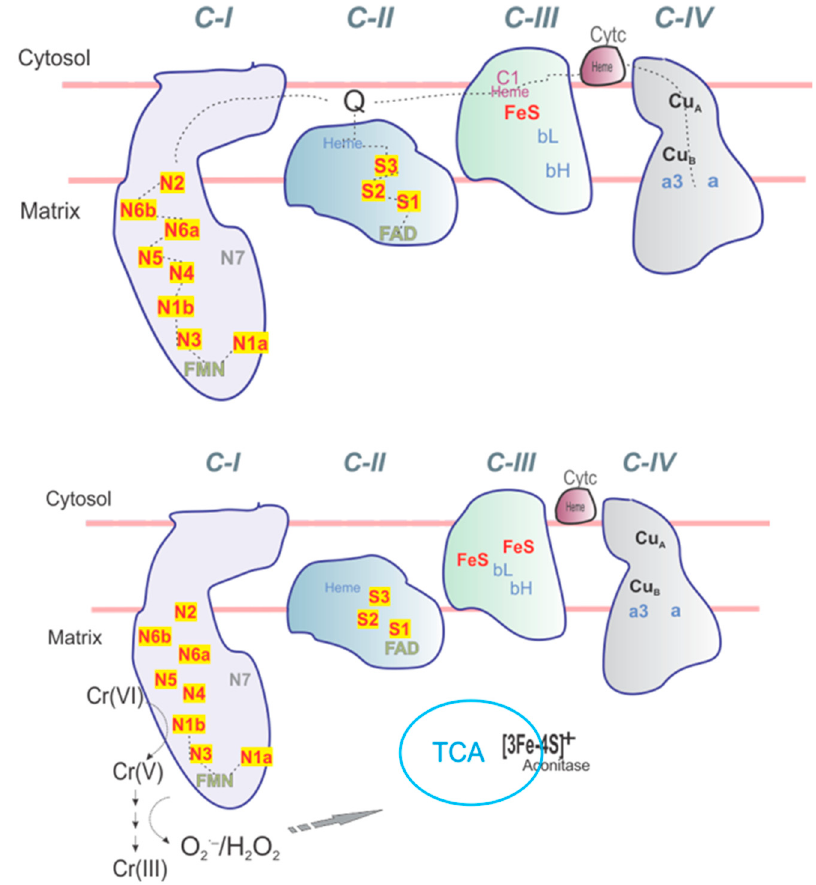
Figure 1. Mitochondrial iron cluster organization and EPR signals. (Upper panel) Mitochondrial Respiratory Complexes (CI–CIV). The hydrophilic domain and iron sulfur clusters of CI: N1a, N1b (2Fe2S) only. N1b is detected at g = 1.94 and 2.02. The clusters N2, N3, N4, N5 are (4Fe4S) with typical signals at g = 2.05 for N2; g = 2.04 and 1.87 for N3; g = 1.89 for N4. Mitochondrial C-II contains S1 (2Fe2S), S2 (4Fe4S) and S3 (3Fe4S) complexes with signals at g = 2.02, 1.93 (S1), g = 2.02 (S3), respectively. (Lower panel) changes in EPR signals upon addition of chromate including contribution of inactive aconitase (3Fe4S)+; g = 2.02. Note: only partial g-values of interest are given for EPR spectra for Fe-S clusters.